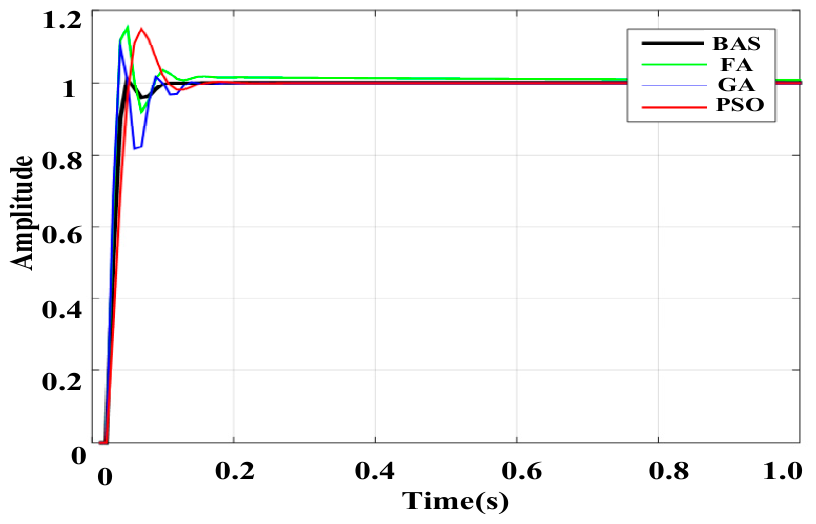
Figure 4. Response curves of the step signal.